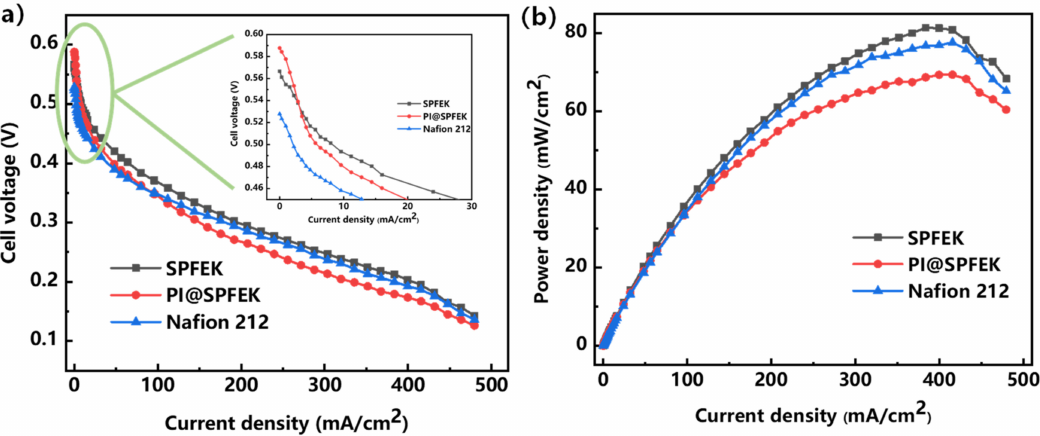
Figure 8. Polarization ( a ) and power density ( b ) curves of SPFEK and PI@SPFEK composite membrane at 80 ◦ C with a 2 M methanol solution.